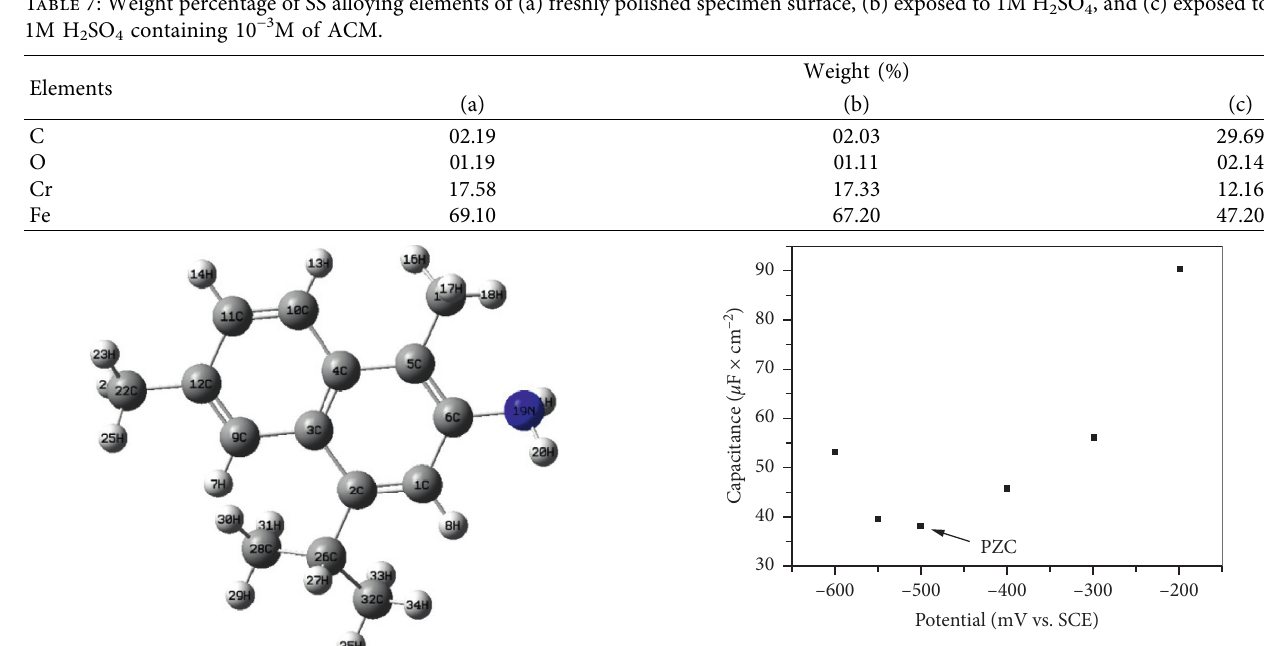
2 SO 4 , and (c) exposed to